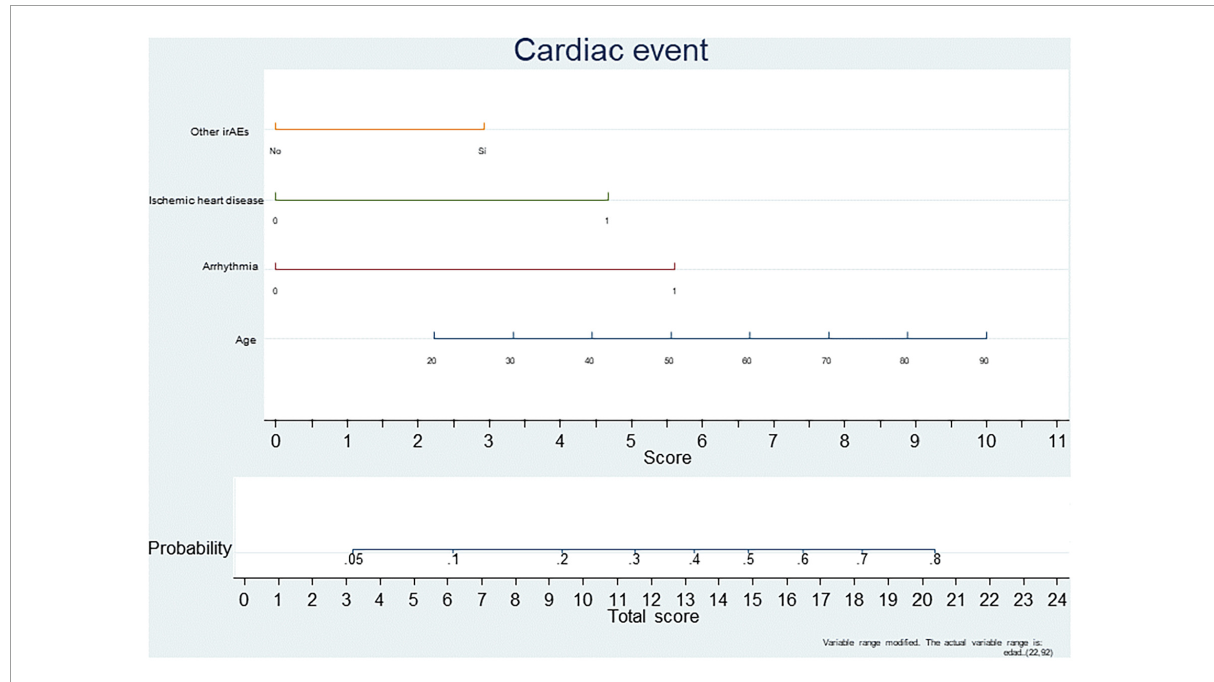
FIGURE2 Predictive risk score for developing a cardiac event during ICI